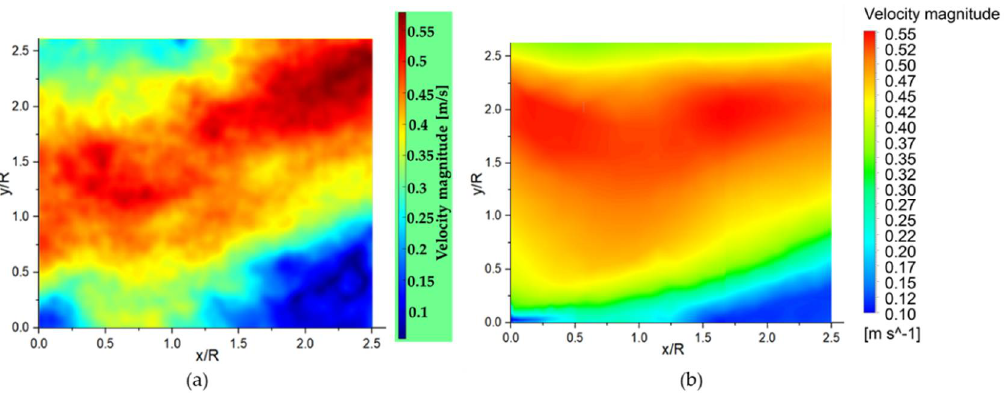
Figure 9. ROIs in CFD simulation ( a ) and PIV experiment ( b ).